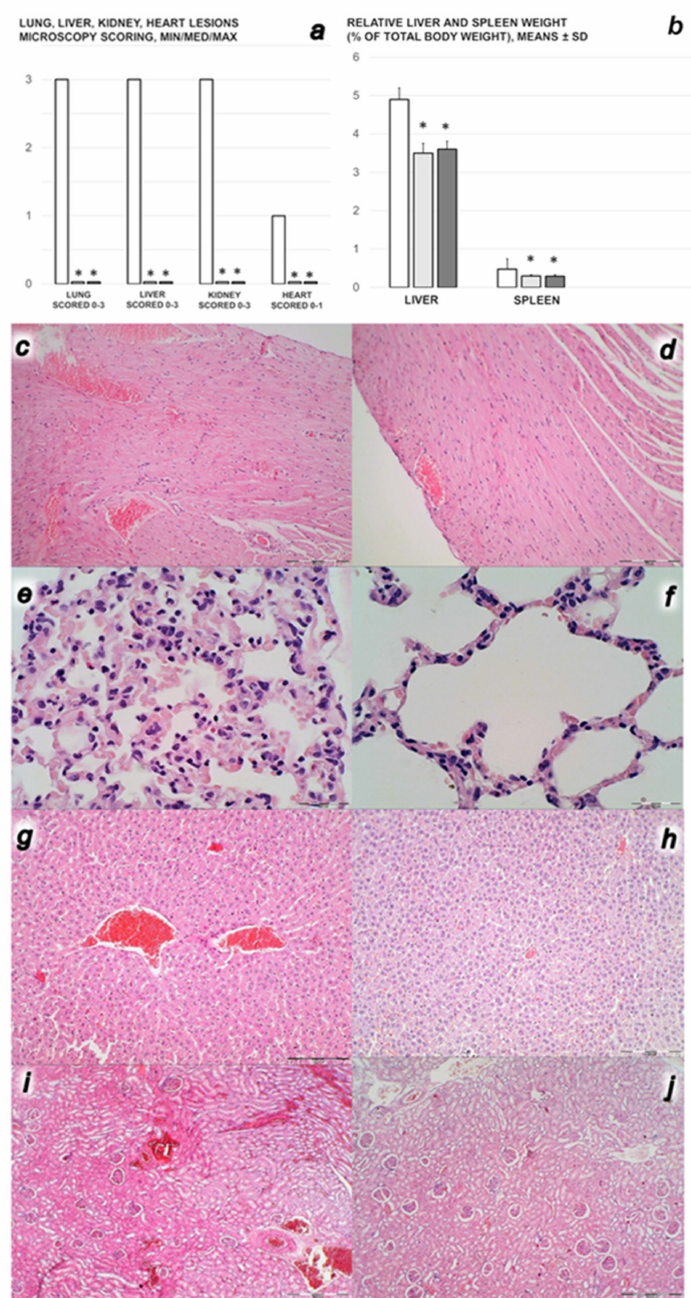
Figure 8. ( a , b ) Microscopy scoring of the lesions of the lung, liver, kidney (scored 0–3) and heart (scored 0–1), Min/Med/Max, ( a ), liver and spleen relative weight (% of total body weight, means ± SD), ( b ), in the rats with ligated superior mesenteric vein at the end of the 30 min period follow- ing medication (BPC 157 10 µ g/kg (light gray bars), 10 ng/kg (dark gray bars); saline 5 mL/kg (white bars)) given intraperitoneally. Six rats/group/interval. * p < 0.05, at least, vs. control. c – j . Characteristic microscopy presentation of the affected organs ( c – j ), heart ( c , d ), marked congestion within myocardium and large coronary branches in controls ( c ), unlike BPC 157 rats ( d ); lung ( e , f ), hyperemia and intraalveolar hemorrhage with margination of inflammatory cells in blood vessels in controls ( e ), unlike BPC 157 rats ( f ); liver ( g , h ), hyperemia in central veins and dilatation of sinusoids in controls ( g ), unlike BPC 157 rats ( h ); kidney ( i , j ), severe cortical and medullar hyperemia in controls ( i ), unlike BPC 157 rats ( j ). (HE; magnification x200, scale bar 50 µ m ( c , d ); × 400, scale bar 20 µ m ( e – f )), magnification × 100, scale bar 100 µ m ( g – j